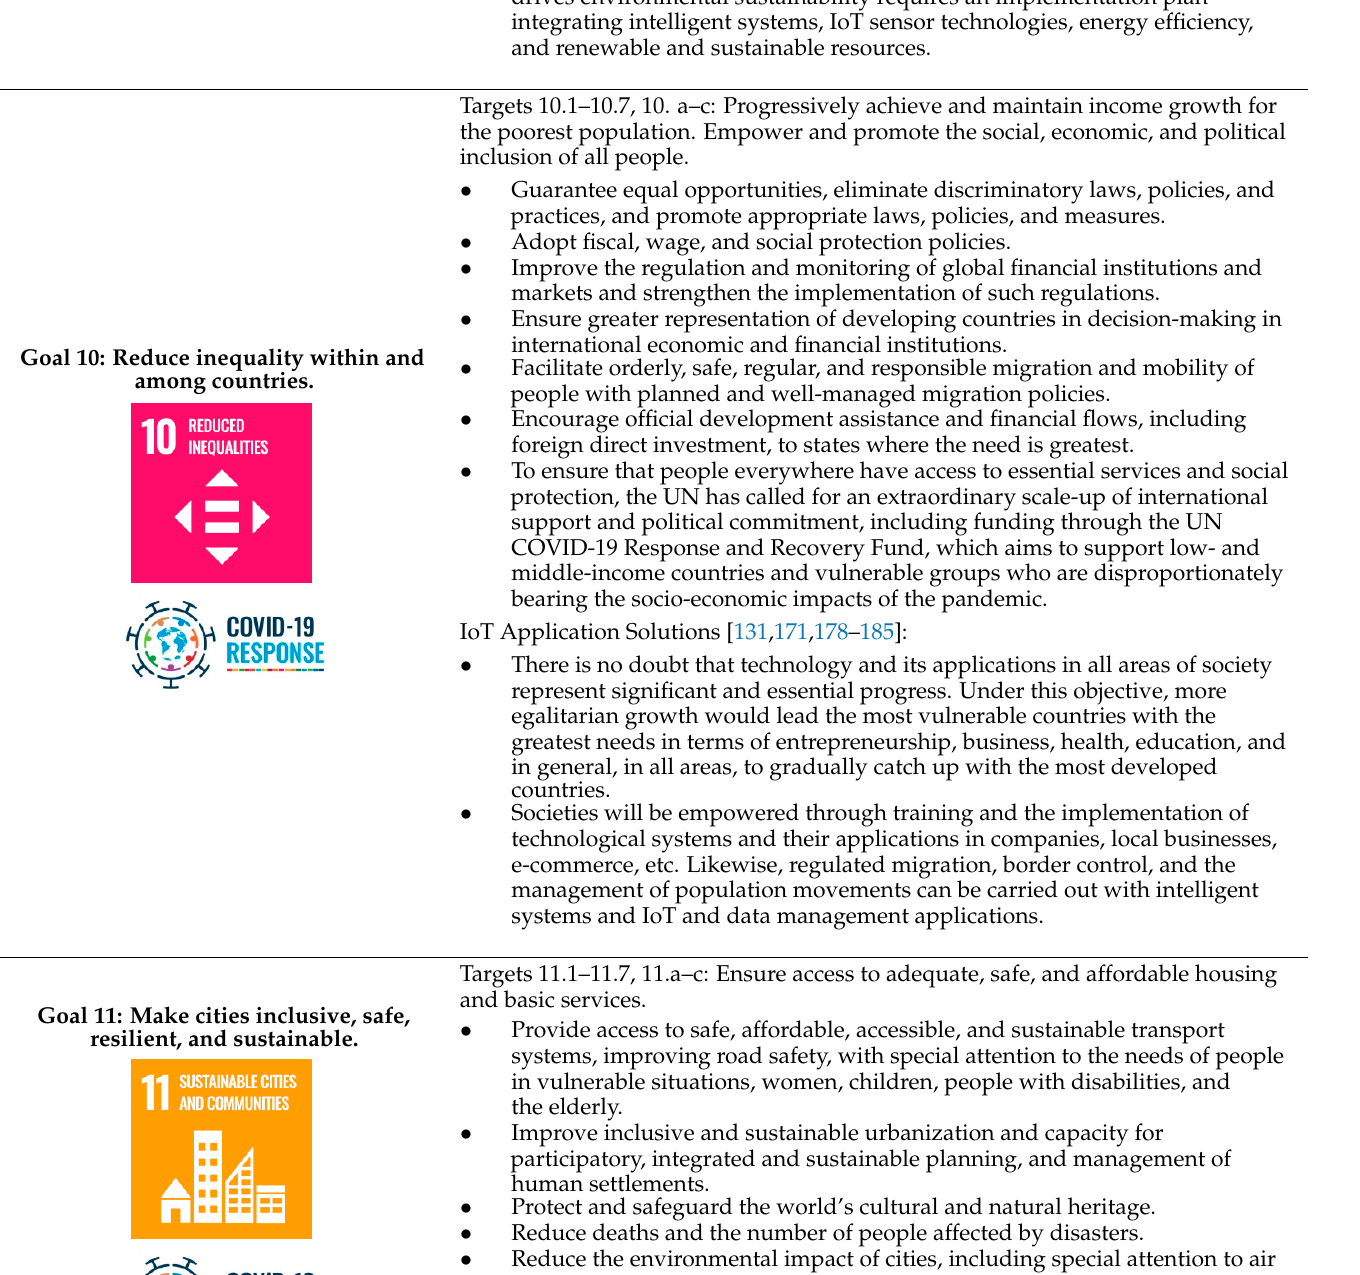
Table 5. Impact of the Sustainable Development Goals on IoT applications for improving health and the environment. SDGs Targets Goals and Application to IoT Systems